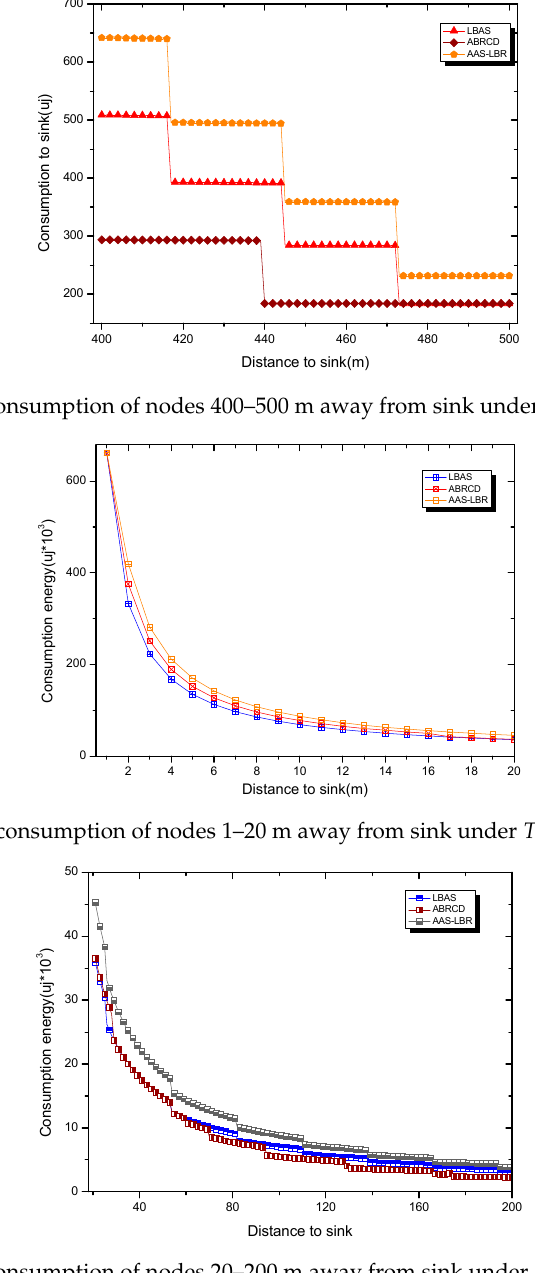
= 100 and r = 28 Figure 32. Energy consumption of nodes 20–200 m away from sink under 𝑇 = 100 and r = 28 m . Figure 32. Energy consumption of nodes 20–200 m away from sink under T Figure 32. Energy consumption of nodes 20–200 m away from sink under 𝑇 = 100 and r = 28 m . Figure 32. Energy consumption of nodes 20–200 m away from sink under 𝑇 = 100 and r = 28 m . Figure 32. Energy consumption of nodes 20–200 m away from sink under 𝑇 = 100 and r = 28 m .